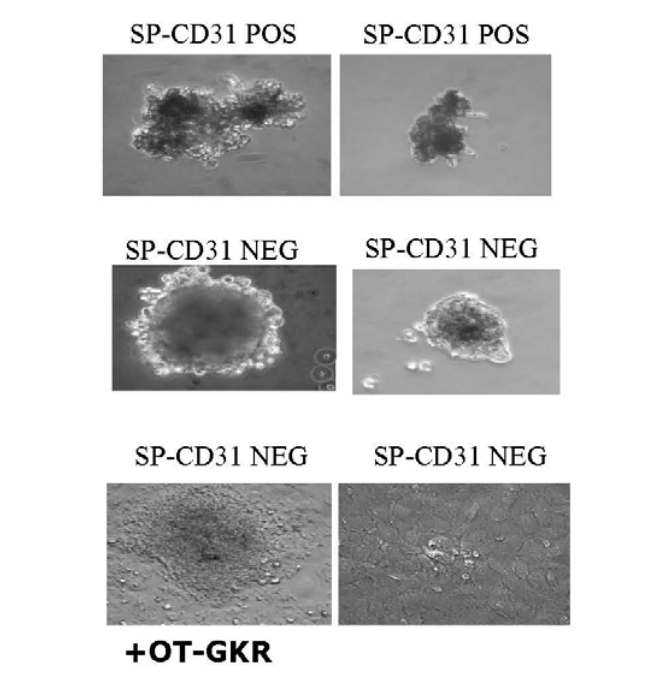
Figure 3. The presence of OT-Gly-Lys-Arg positively influences the shape and size of aggregates of the CD31 NEG subpopulation of side population cells (SPs) isolated from the rat